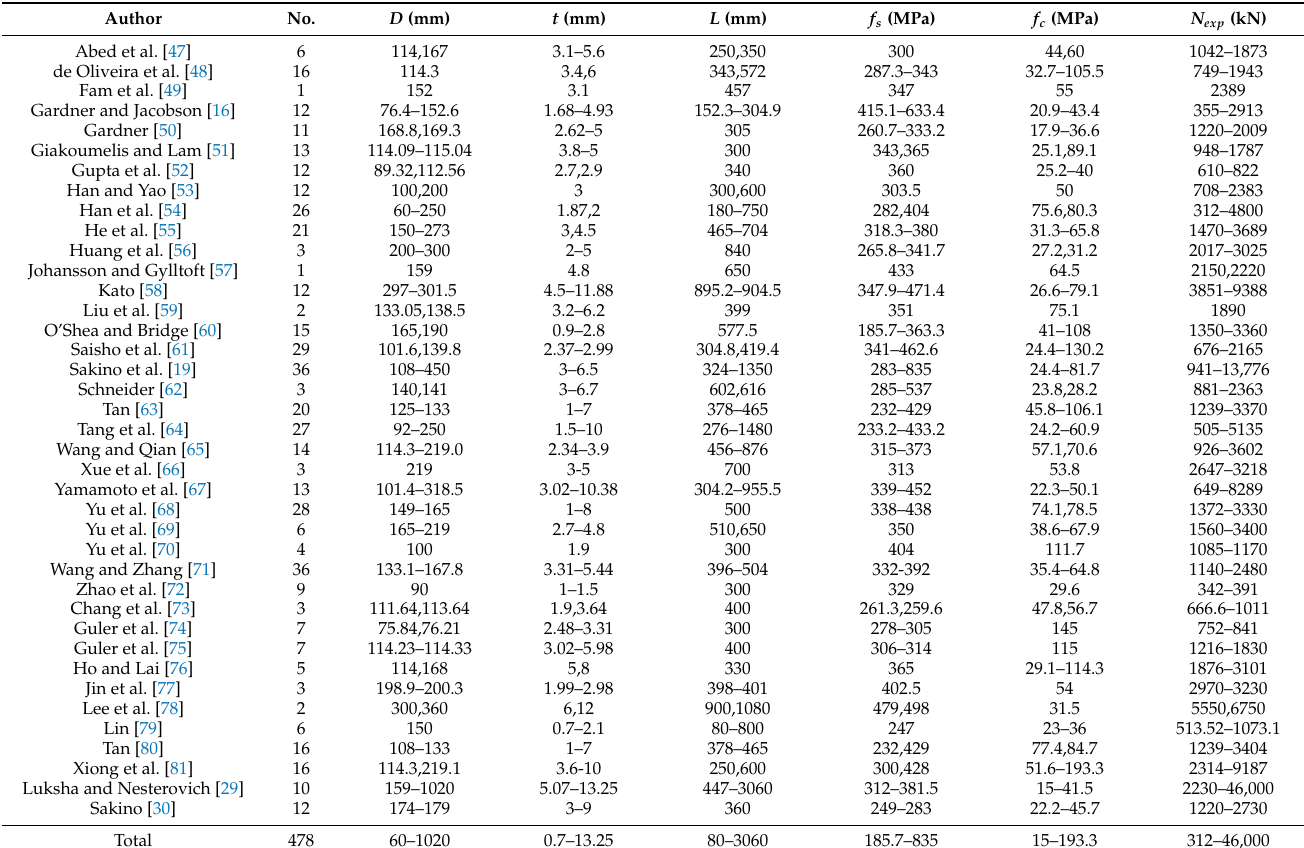
Table 1. Test data available in the